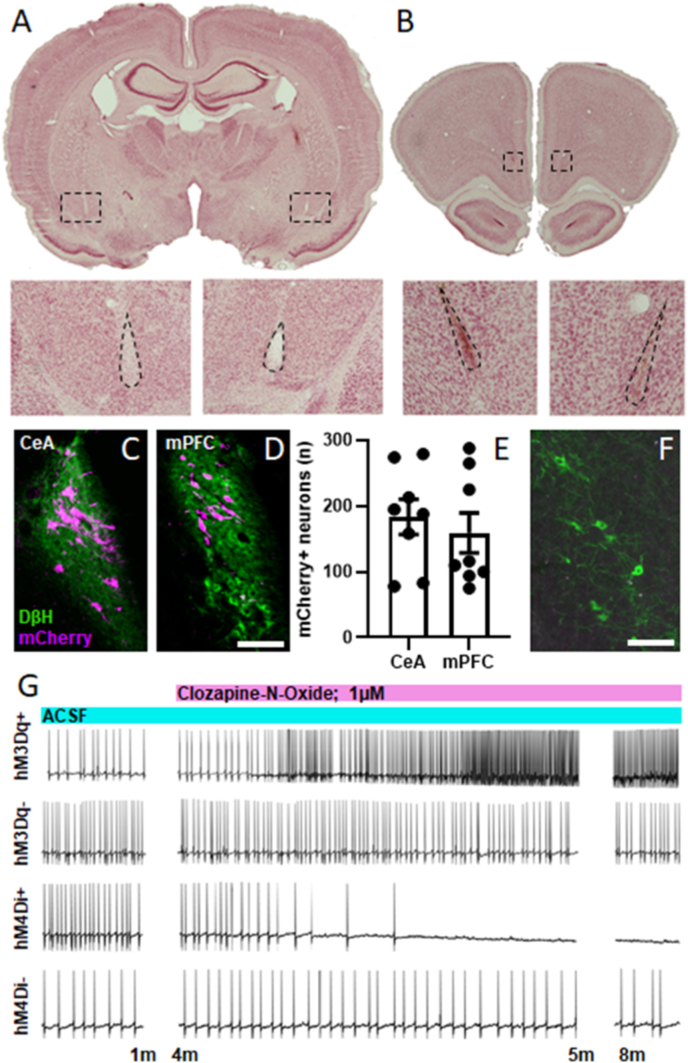
A retrograde viral-genetic technique permits experimental manipulation of LC neurons innervating specific terminal fields. Rats received bilateral injections of CAV2-PRS-CreV5 in CeA (n = 8) or mPFC (n = 8) and bilateral injections of Cre-inducible AAV-DIO-hM3Dq-mCherry or AAV-DIO-hM4Di-mCherry in LC. Representative images of injection sites in CeA and mPFC are shown in A&B, respectively. Boxes in low power images show the locations of high power images underneath. Areas enclosed in dotted lines in high power images show cannula tracks in CeA and evidence of minor glial scarring in mPFC that resulted from viral injections. Representative images of transduced neurons projecting to CeA and mPFC are shown in C&D, respectively. (E) These manipulations result in similar numbers of transduced neurons within each population. Noradrenergic neurons outside of LC were not found to express mCherry after these injections. A representative image of noradrenergic neurons in A5 is shown in F. Whole-cell recordings show that an hM3Dq + neuron increased its firing rate and an hM4Di + neuron was silenced in response to bath application of 1 μM CNO, respectively. Neurons lacking hM3Dq and hM4Di were insensitive to CNO (G). Scale bars in C, D&F = 100 μm.